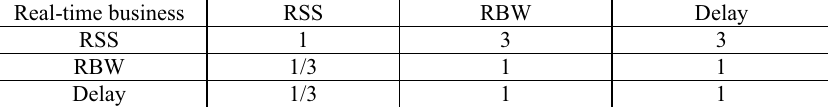
Table 3. Real-time business non-critical variables pairwise comparison matrix.